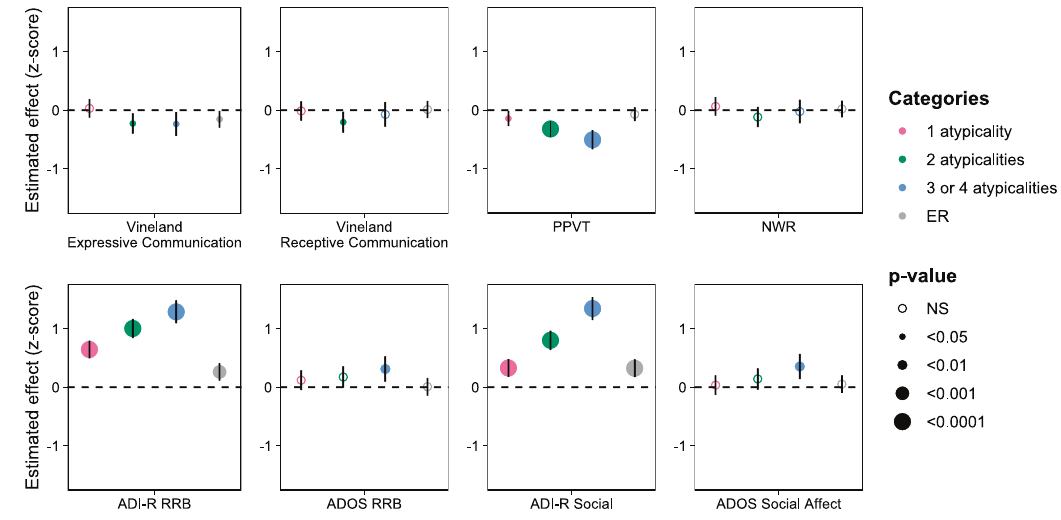
Fig. 2 Signi fi cant effects of combinations of atypicalities and ER on the areas of communication, language, and severity of symptoms. Standardization of outcome measures allows visual appreciation of effect size. The four atypicalities are as follows: “ hand leading — ever ” , “ pronominal reversal — ever ” , “ never shakes head at age 4 – 5 ” , and “ stereotypic use of objects or interest in parts of objects — ever ”